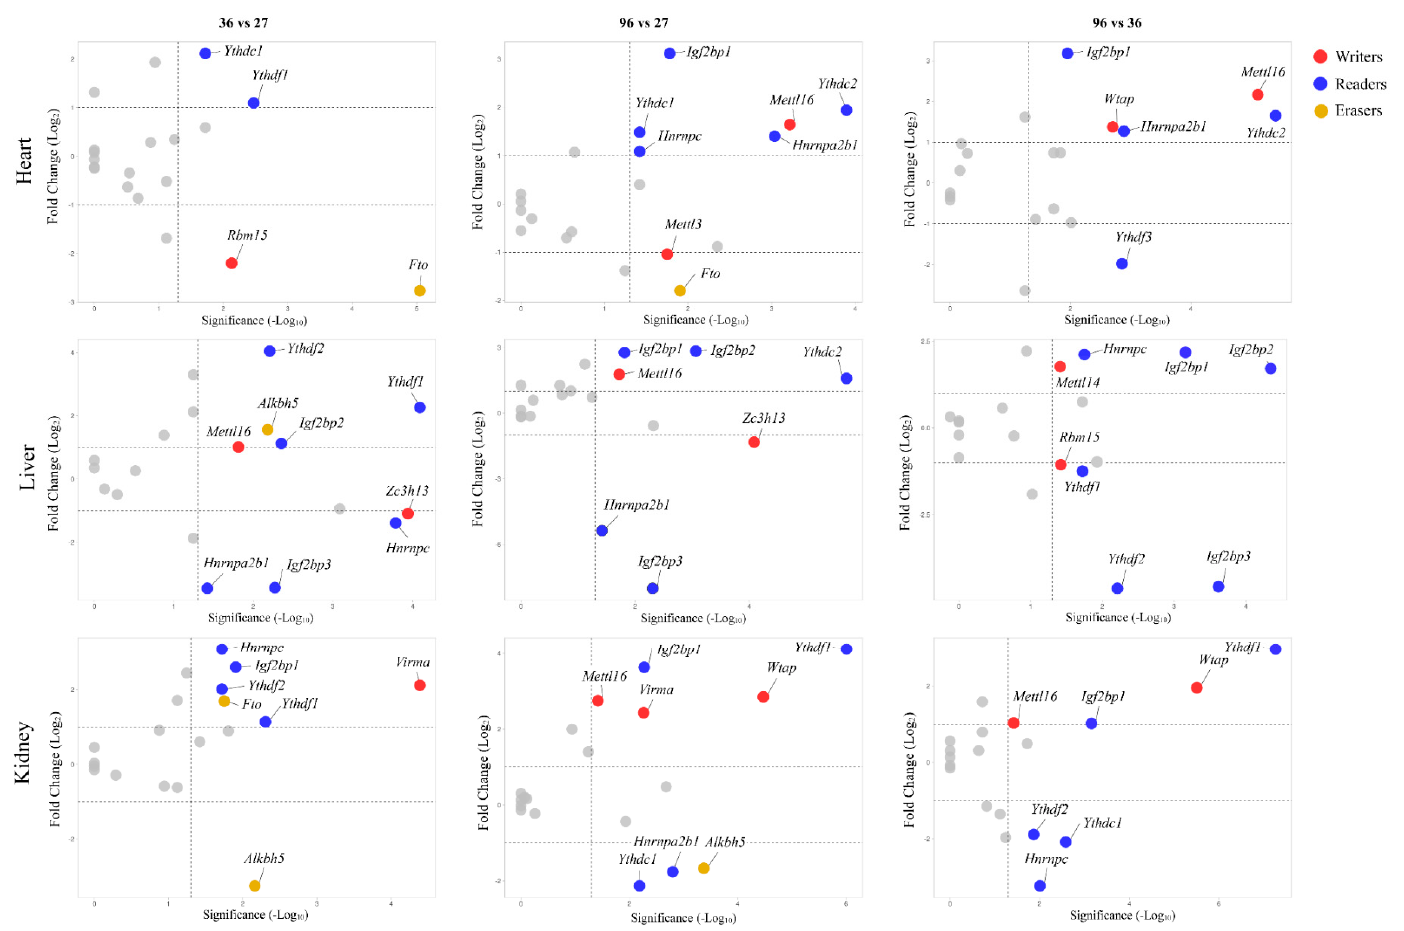
Figure 2. Changes in the expression of writer, reader, and eraser genes in the heart, liver, and kidney from rats during age. The values are reported as log 2 FC (fold change) calculated as the ratio of the mRNA levels between 36 and 27, 96 and 27, and 96 and 36 weeks of age. Scattered points represent all the analyzed genes; red, blue, and yellow dots represent writer, reader, and eraser genes, respectively, that encounter significant differences in levels of expression with age. Grey dots represent unregulated genes. The x-axis represents the Bonferroni p -value adjusted in − log 10 format, the y-axis shows the log 2 ratio of gene expression levels of one gene at two different ages. The dotted lines represent Bonferroni cut-off ( p -values < 0.05) and the two-fold